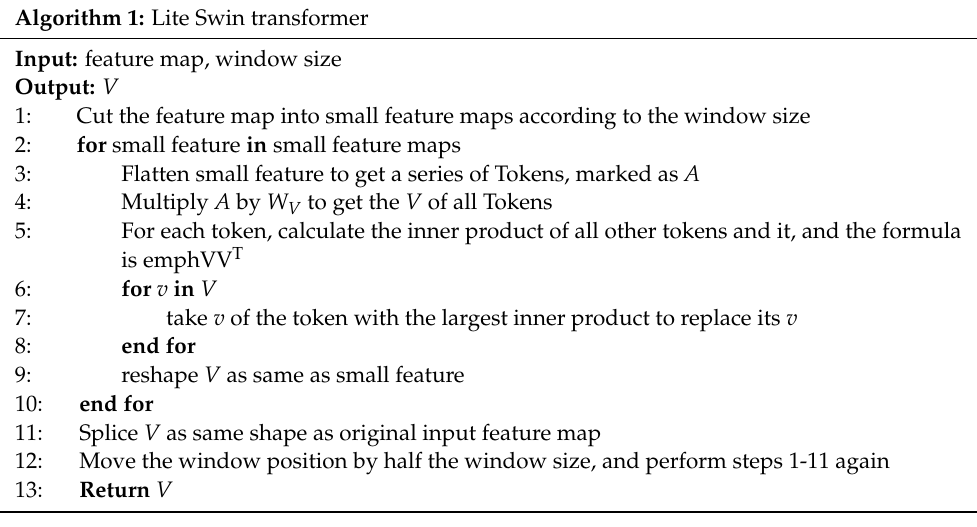
Figure 3. Schematic diagram of maximum weight replacement of the Lite Swin transformer. The number is the sequence number of the pixel, and the color is the feature value of the pixel, that is, v in Lite Swin transformer. ( a ) is the feature map before the Lite Swin transformer, and ( b ) is the feature map of the first pixel after being calculated by the Lite Swin transformer.